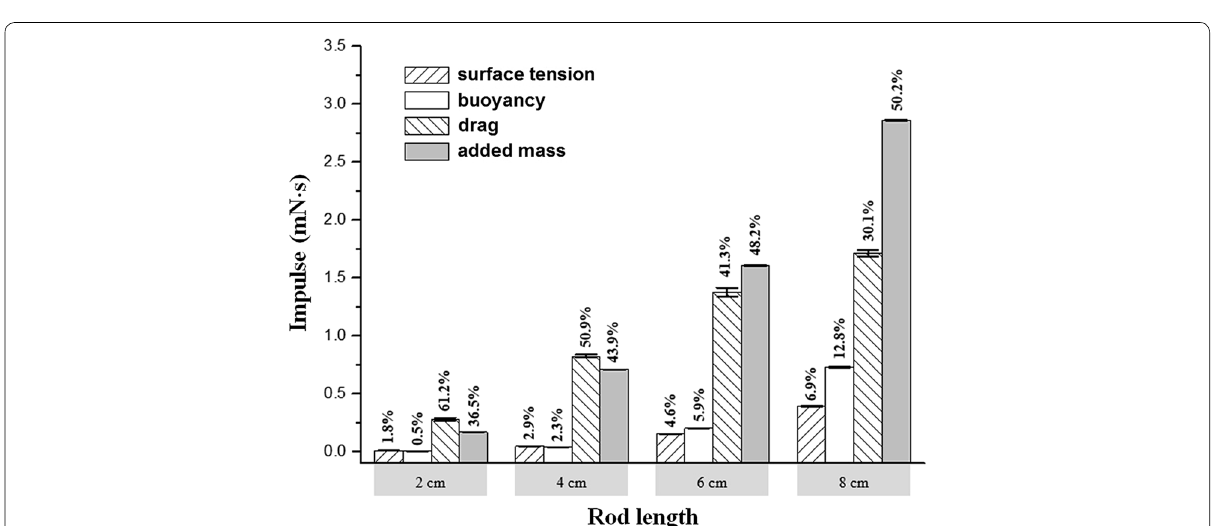
Fig. 7 The ratios of each impulse element over the total impulse of each rod